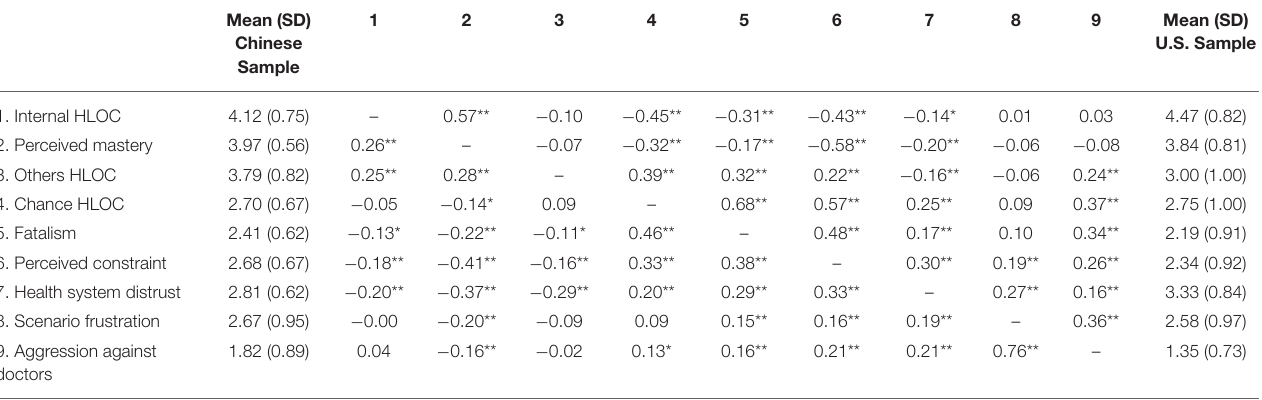
TABLE 1 | Within-country zero-order correlations and descriptives (Study 1).